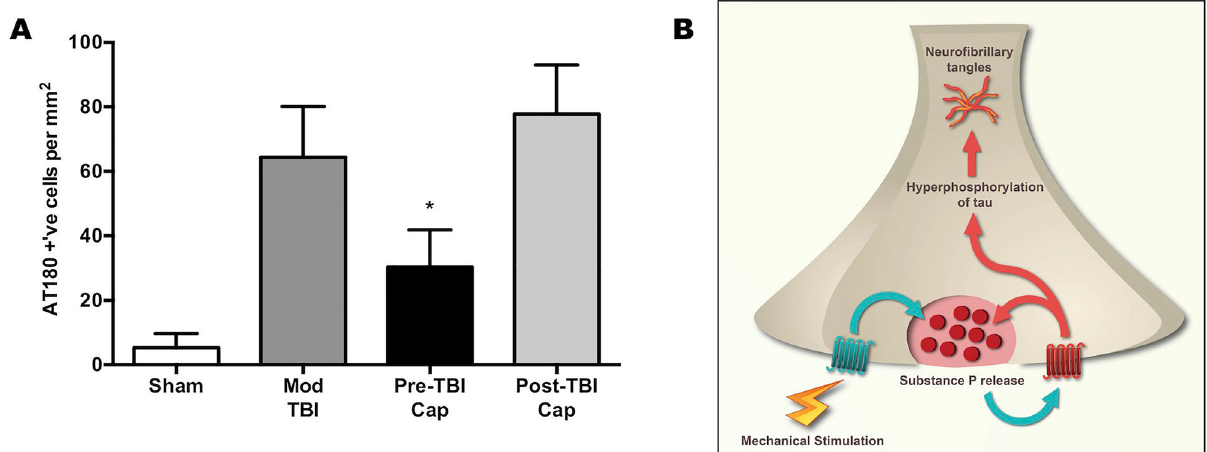
Figure 4. (A) Effects of the TRPV1 antagonist, capsazepine (Cap), on 24 h tau phosphorylation (AT180) when administered 30 min prior to or 30 min following moderate TBI. Capsazepine administration significantly reduced tau phosphorylation only when administered prior to injury. Mean ± SEM; n = 6/group; * = p < 0.05 versus nontreated animals. (B) Schematic summarizing mechanisms associated with tau phosphorylation following concussive and blast brain injury. Mechanical stimulation of transient receptor potential (TRP) receptors initiates substance P release, which binds to NK1 receptors. NK1 receptor stimulation activates kinases that then phosphorylate tau, leading to neurofibrillary tangles. Repeated or high intensity NK1 receptor activation can also promote further substance P release 5